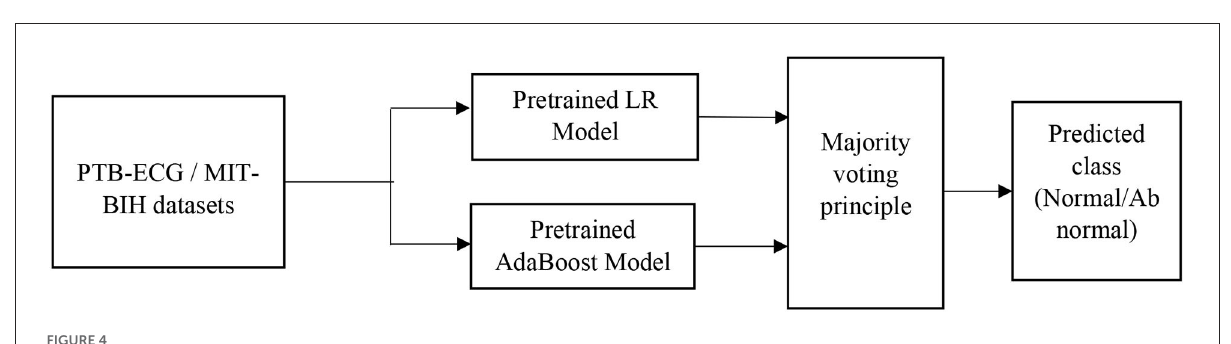
FIGURE3 Block diagram of AdaBoost classification model.